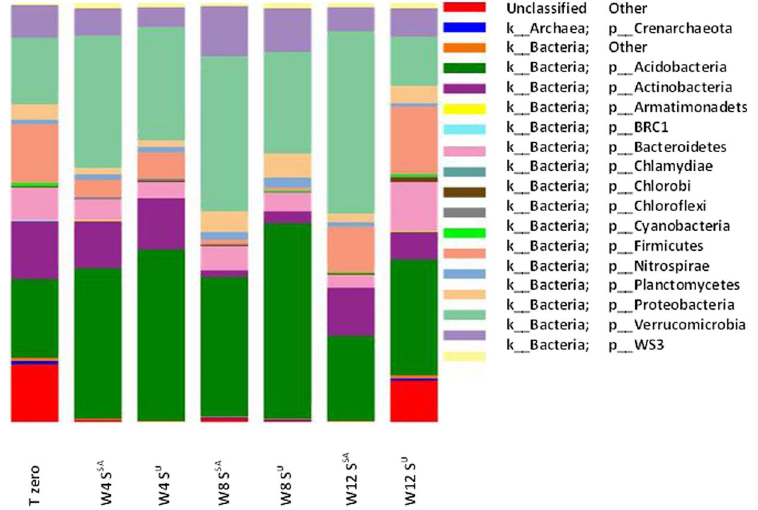
Figure 2. Microbial phylum abundance determined through pyrosequence analysis of 16S rRNA genes at time zero and following 12 weeks of incubation under both sulfur amended (S SA ) and untouched soil (S U ). Phyla were determined by analysis through the Quantitative Insights Into Microbial Ecology (QIIME) associated pipelines 56 . Taxonomy was then assigned using the GreenGenes reference database 66 . T = time, W = week, S SA = Sulfur amended soil and S U = unaltered